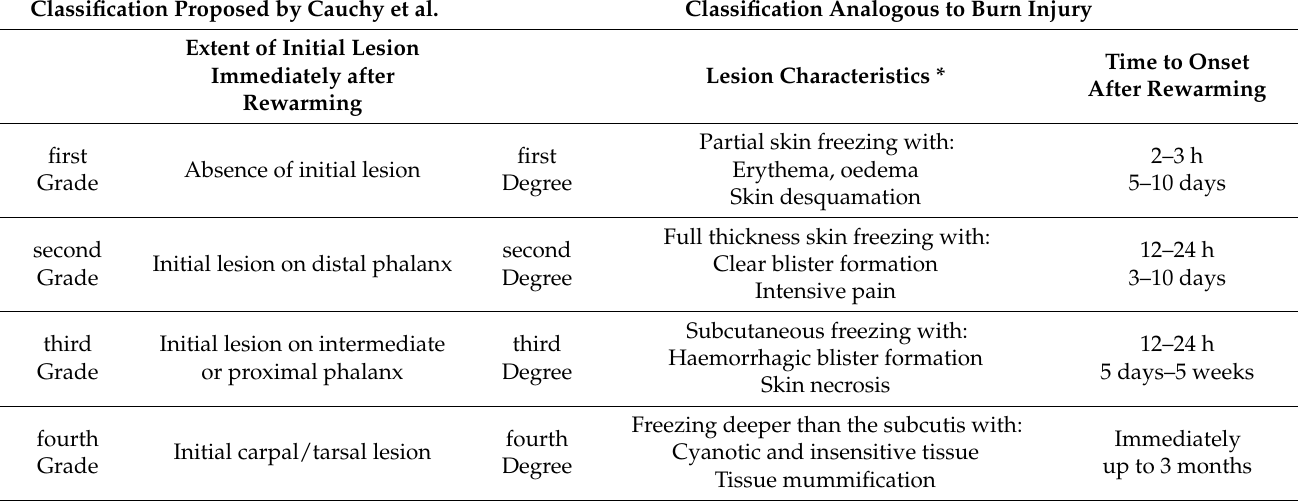
Table 1. Classification of